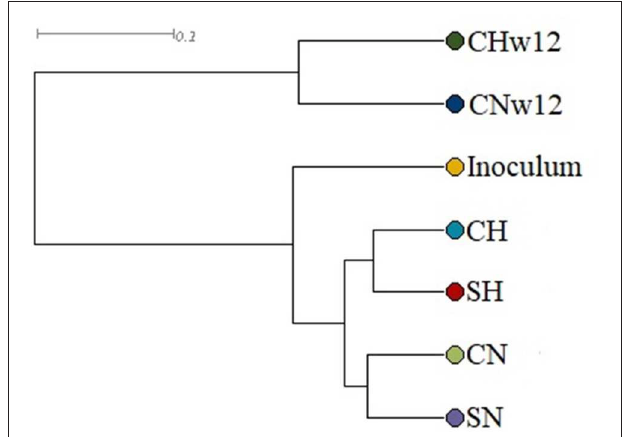
FIGURE 4 | UPGMA grouping of the samples. The compositions of the reactors were as in Figure 3 .